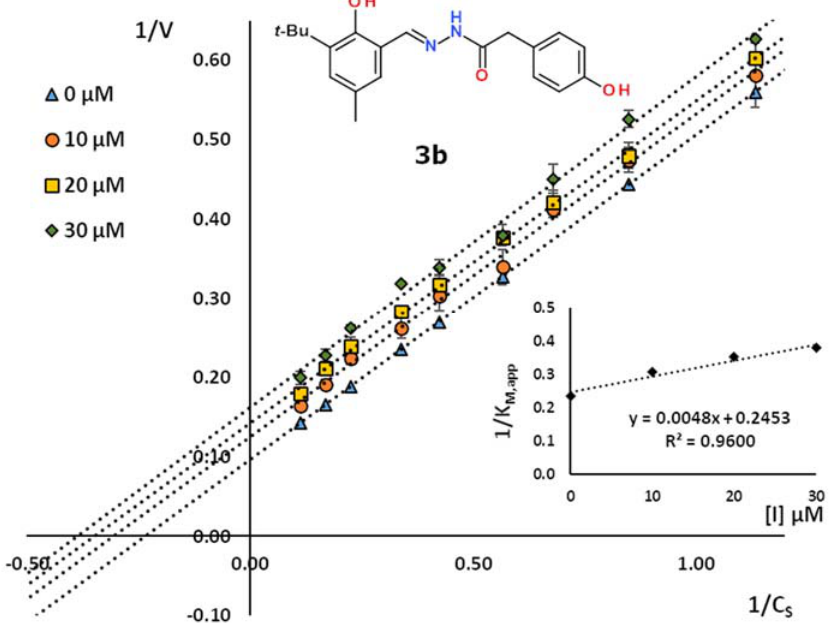
Figure 4. The Lineweaver–Burk plots (1/V [min · µ M − 1 ] = f(1/C S ) [ µ M − 1 ]) for 3b performed for the inhibitor concentration up to 30 µ M. The additional graphs show the linear dependence of 1/K M,app = f(I) [ µ M] related to the uncompetitive